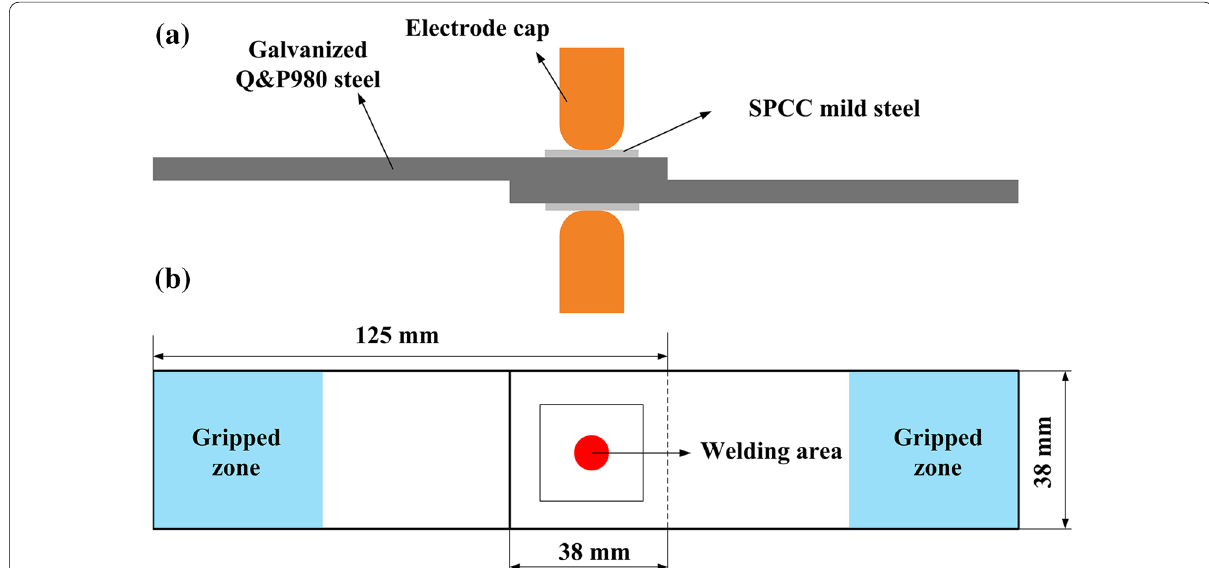
Figure 1 Schematic of ( a ) welding set-up of RSW with double-sided cover sheets and ( b ) configuration of the samples